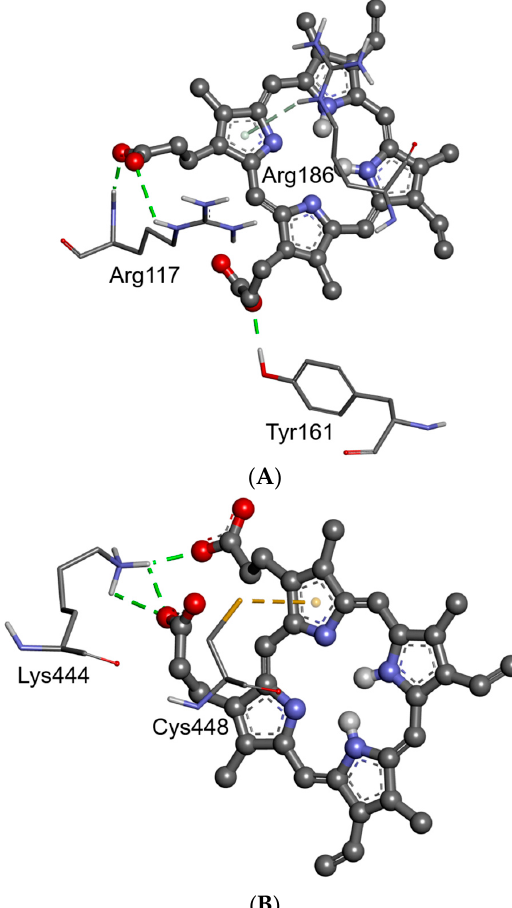
Figure 10. Hydrogen bonds and miscellaneous (sulfur) interactions between the residues of HSA and the molecules of PpIX in the hemin site ( A ) and Sudlow’s Site 1 ( B ). Interactions between ligand and amino acids are visualized in dashed lines and colored according to their type (conventional and non-classical H-bonds are green and olive; the miscellaneous interaction is yellow). Ligands and are shown in the ball and stick representation, respectively.